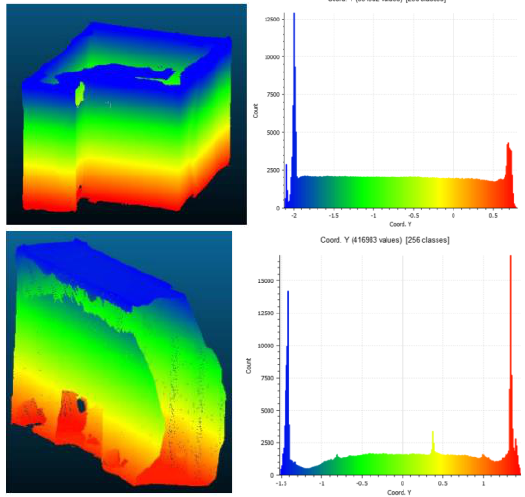
Figure 22. Point cloud exported in scalar value of Y for each case on the left and their altitude histogram on the right.